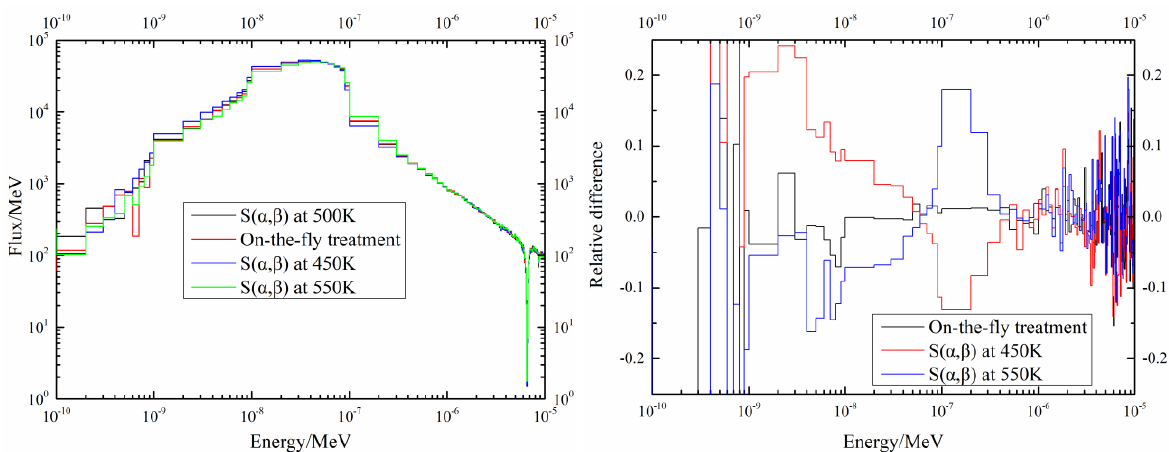
Figure 4. Comparison of energy